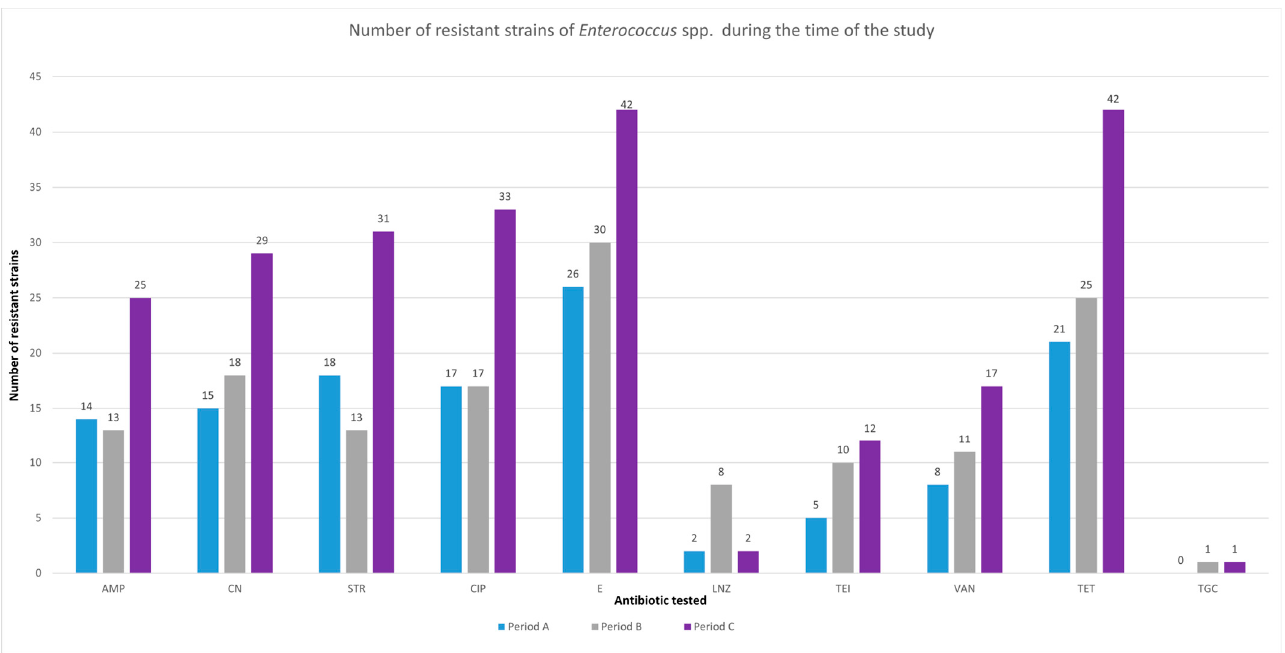
Figure 2. Distribution of Enterococcus spp. resistant strains over the period of this study. Abbrevia-